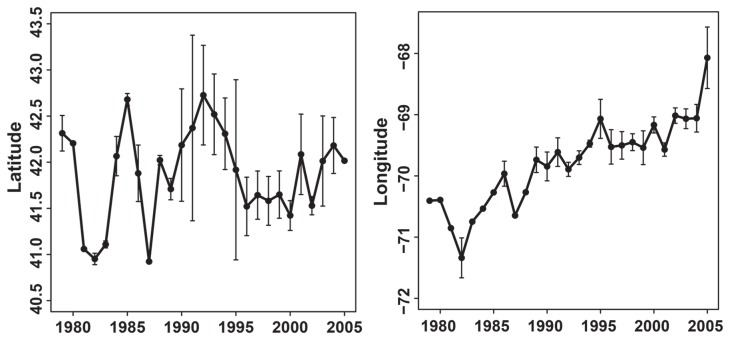
Surface school positions of Atlantic bluefin tuna in the Gulf of Maine.Each location represents the mean position of bluefin schools observed by spotter pilots, from vessels or represents captured fish from the commercial fishery. Within each year, mean positions were weighted by the number of fish in each school. Error bars represent sample variance. Schools of Atlantic bluefin tuna have shifted their longitudinal distribution approximately 280km to the east (70.95 to 68.47° W).